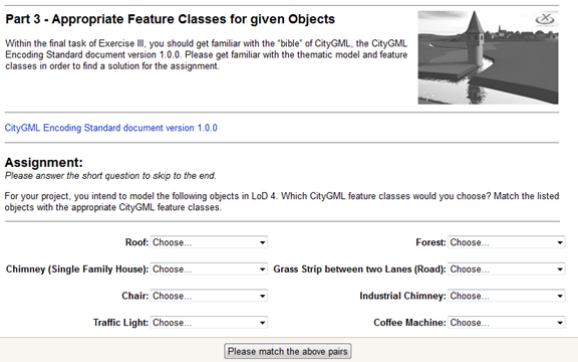
Figure 3: Exercise